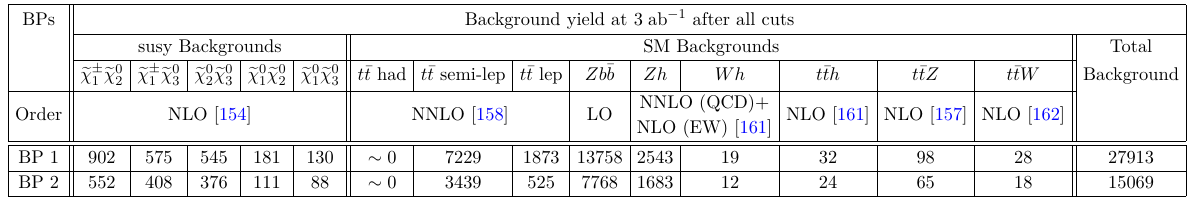
Table 13. The cut-flow table for the benchmark point 1 in the b ¯ b + /E production and dominant backgrounds.